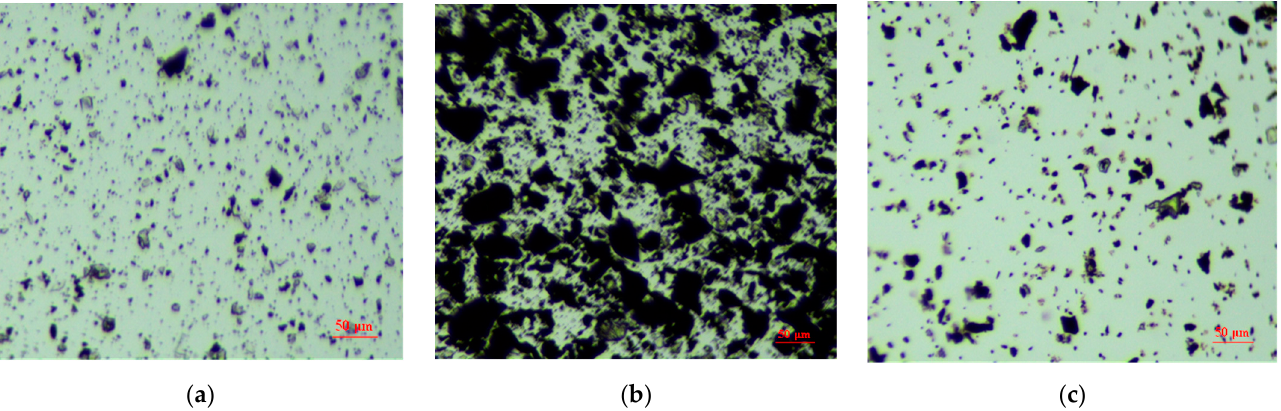
Figure 10. Microscopy images of oxidized digenite fine particles with different treatments ( a ) with deionized (DI) water; ( b ) with 1.25 × 10 − 3 mol/L Na 2 S + 1 × 10 − 4 mol/L SBX; ( c ) with 1 × 10 − 3 mol/L Fe 3+ + 1.25 × 10 − 3 mol/L Na 2 S + 1 × 10 − 4 mol/L SBX).